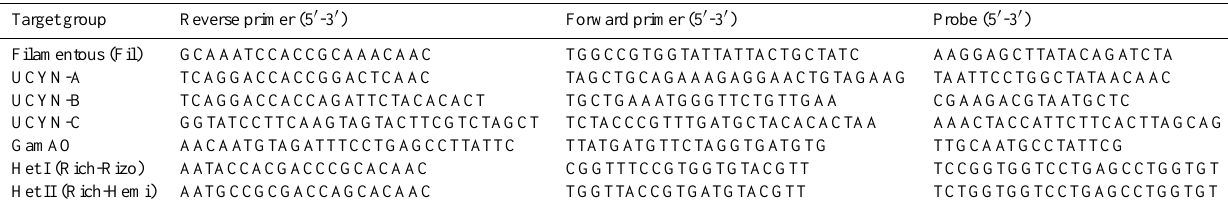
Table 1. Primers and probes used in nifH TaqMan qPCR assays. Target